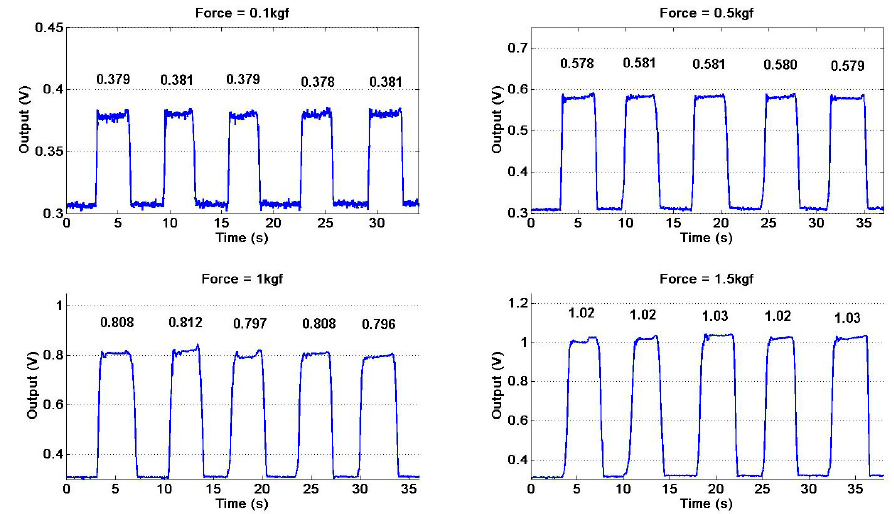
Figure 5. The repeatability of the sensor under different forces: 0.1 kgf, 0.5 kgf, 1.0 kgf and 1.5 kgf.